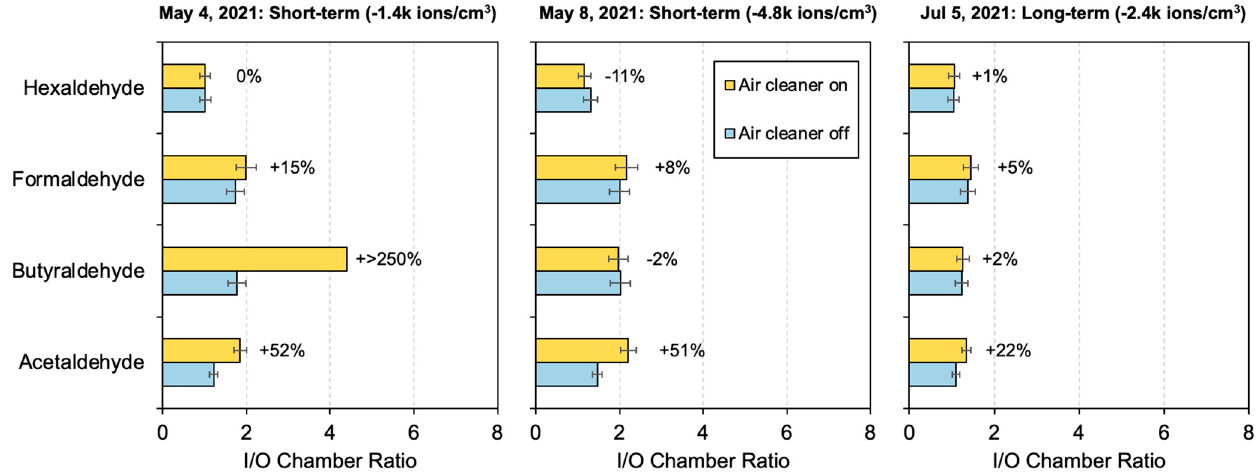
Figure A6. Inside/outside (I/O) chamber concentration ratios measured during air cleaner on and off conditions, as well as the percent difference between air cleaner on and off conditions, for five compounds on the TO-11A analyte list that were detected above reporting limits (RLs) in nearly every sample collected during the three natural condition chamber tests (two short-term and one long-term).